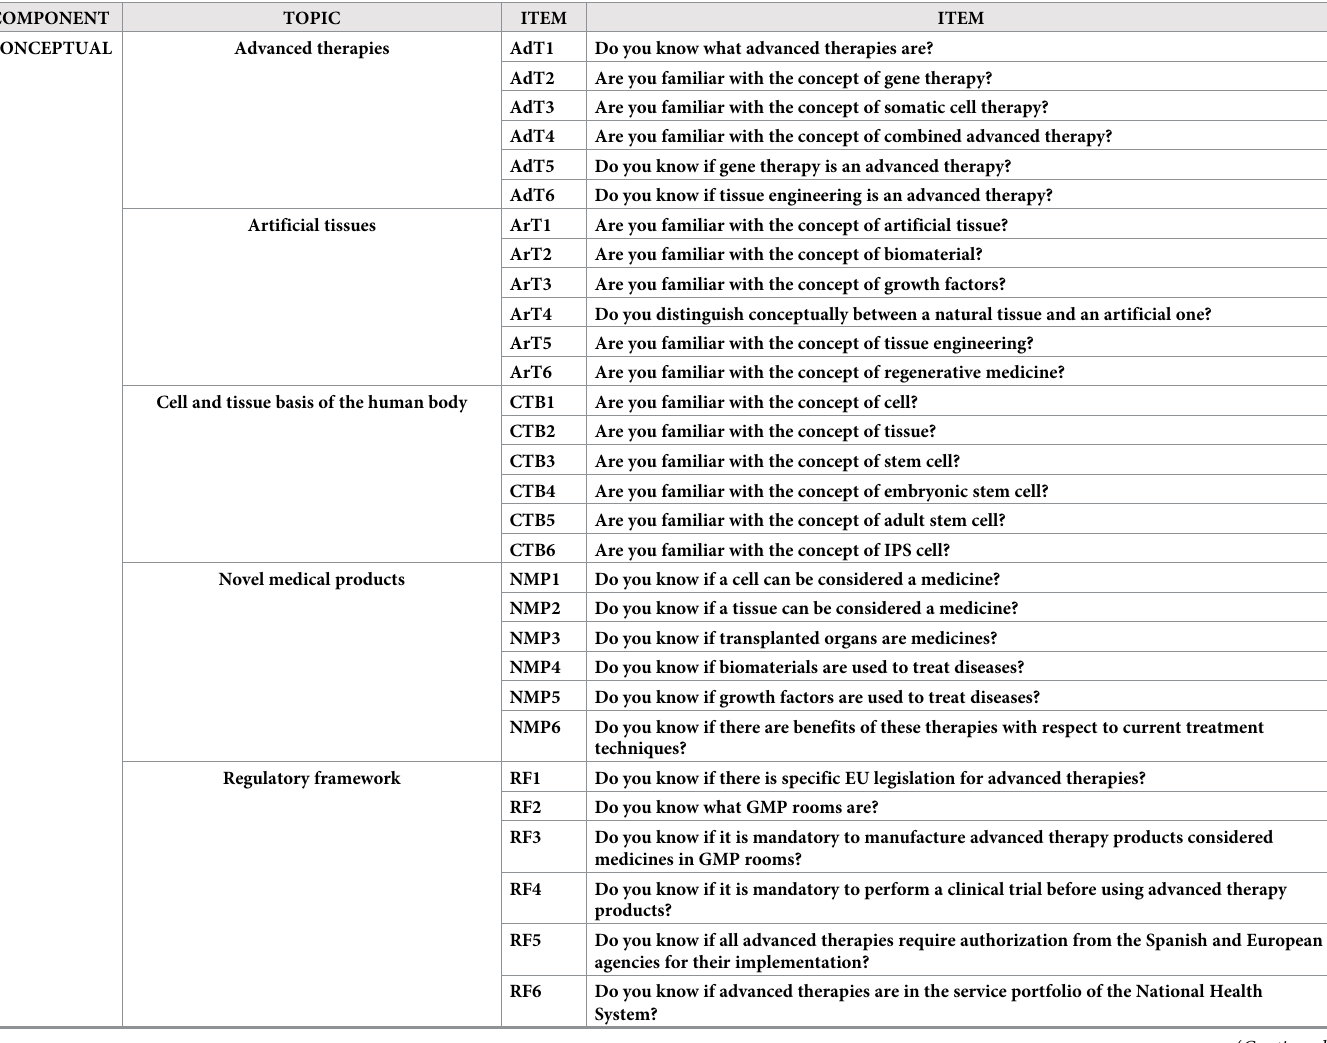
Table 1. Items in the questionnaire corresponding to different components and topics. For each item, both the full question and its abbreviated item name are shown. COMPONENT TOPIC ITEM